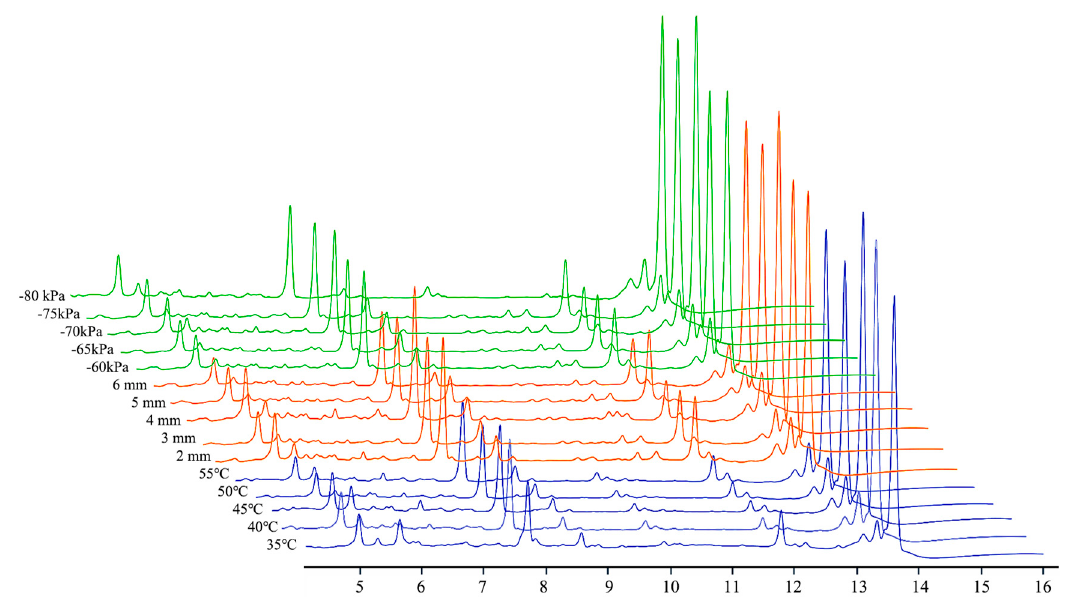
Figure 6. HPLC chromatograms of the natural active ingredient contents under different drying Figure 6. conditions. Table 3. The content of natural active ingredients in Angelica sinensis dried before and after micro- wave vacuum drying.